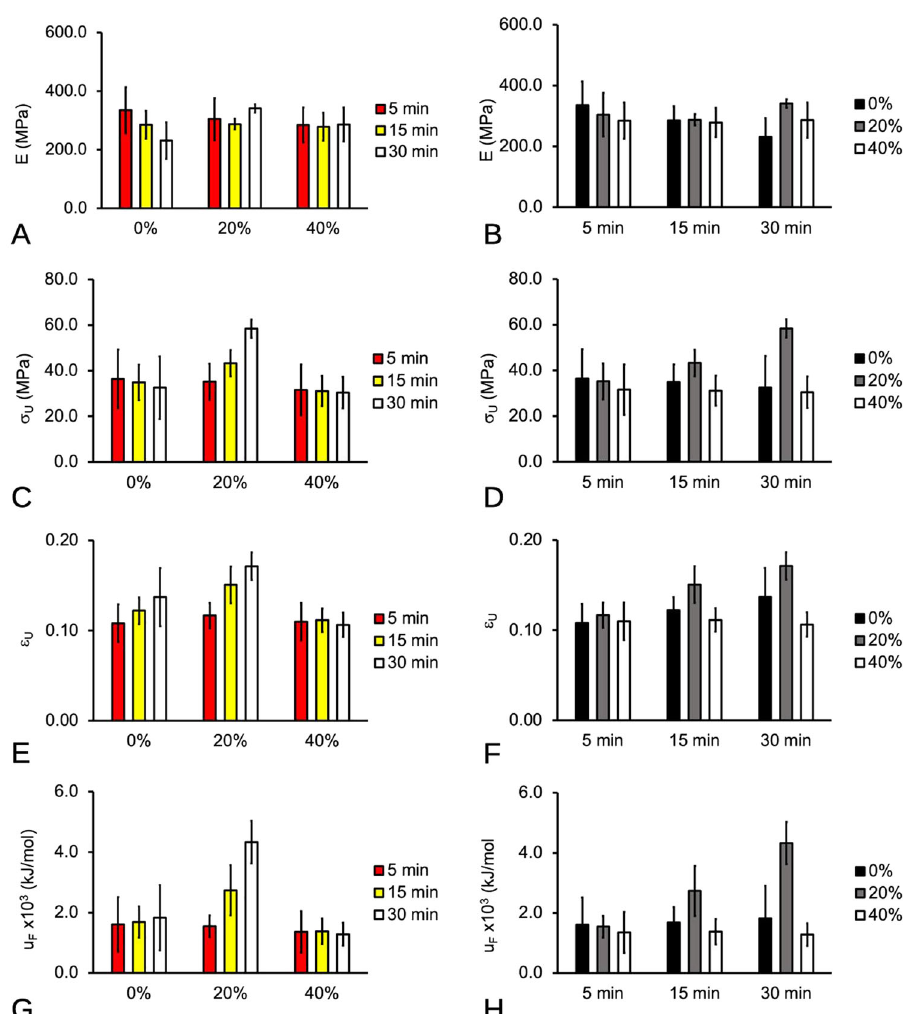
Fig. 8 Interaction plots of the mechanical properties of PLGA/ PVA scaffold with respect to sonication power ( p W ), and soaking duration ( t ). A , B Stiffness, E . C , D Fracture strength, σ U . E , F Strain